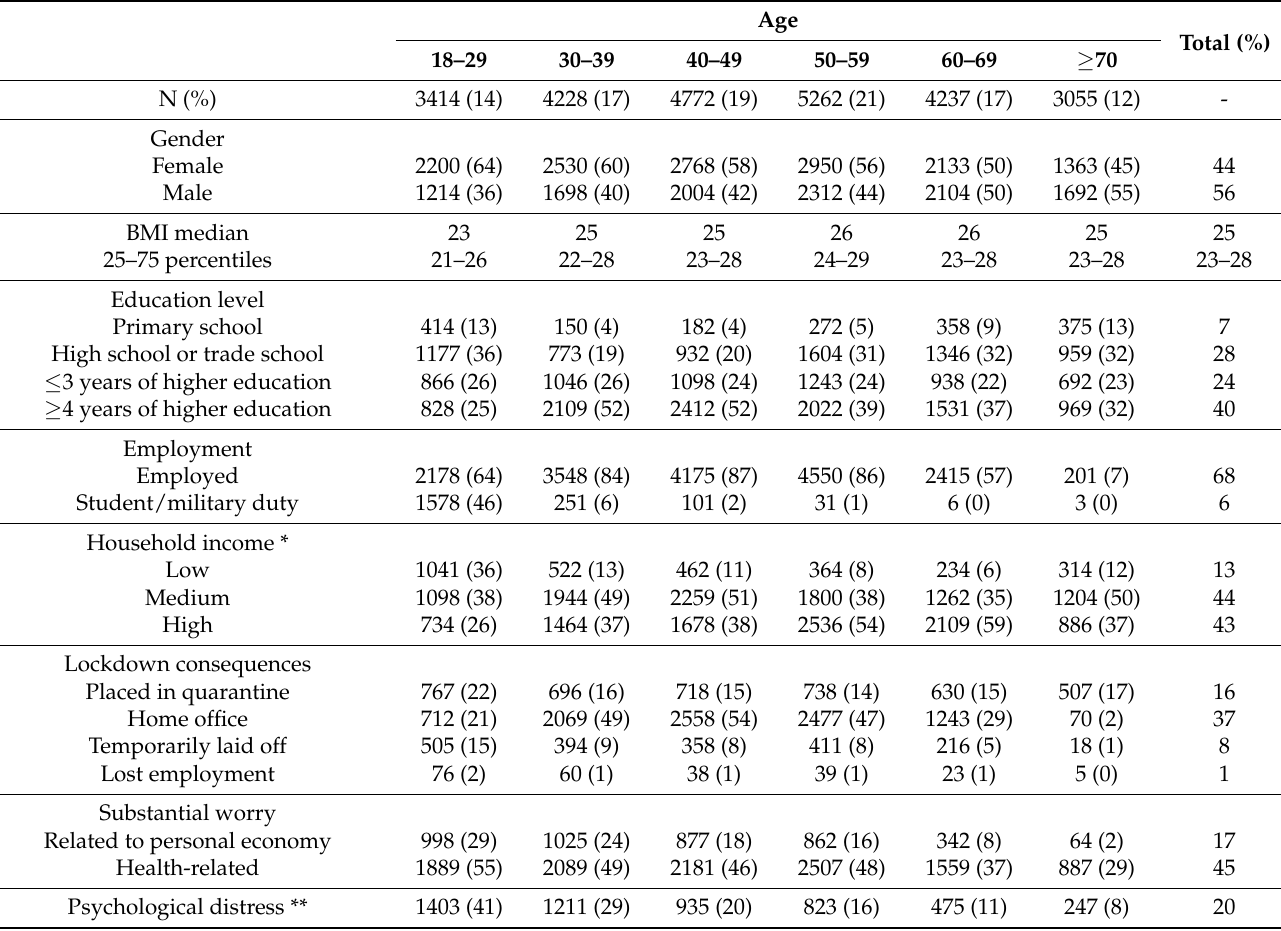
Table 1. Demographic characteristics, worries, and mental distress in the sample